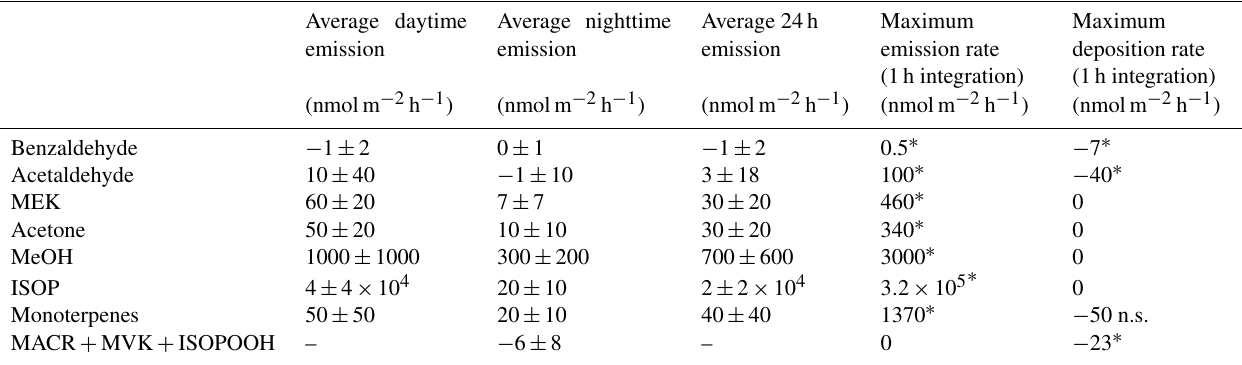
Table 2. Average measured emission and deposition rates at branch scale in the upper canopy (25 August–1 September). Data are reported as mean ± standard deviation. Maximum emission and deposition rates are also reported as well as an indication of their statistical significance ( ∗ indicates p< 0 . 05; n.s. indicates not